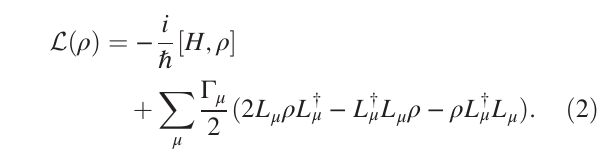
FIG. 1. (a) Schematic sketch of the experimental measurement. Atoms confined in a 3D optical lattice (only one plane is shown) are continuously excited to the Rydberg state with Rabi frequency Ω and detuning Δ > 0 . The Rydberg atoms are ionized at the rate Γ , which is much smaller than the natural ion decay rate. Therefore, the ions serve as a probe of the excitation dynamics. The color scheme of the atoms is chosen according to the rates in (c): Rydberg excitations are red, ground-state atoms are gray, and atoms that can be facilitated are blue. (b) Pair- correlation function g ð 2 Þ ð τ Þ deduced from the ion signal ( Ω ¼ 2 π × 77 kHz, Δ ¼ 2 π × 13 MHz). The correlation func- tion shows super-Poissonian fluctuations with large bunching amplitude g ð 2 Þ ð 0 Þ ≫ 1 and relaxation time τ ð 2 Þ ≫ τ , where sp τ 20 μ s is the natural lifetime of the excited Rydberg sp ¼ state 25 P 1 . Inset: Measured ion signal for single (blue) and = 2 averaged-over-40 (gray) experimental realizations. The shaded area around the gray line denotes Poissonian fluctuations. (c) Effective cluster model: A single seed excitation with rate Γ N initializes the growth of a cluster. While a facilitation at seed rate Γ ↑ ≫ Γ leads to an increase of cluster size m , the seed spontaneous decay rate Γ limits the size of a sp